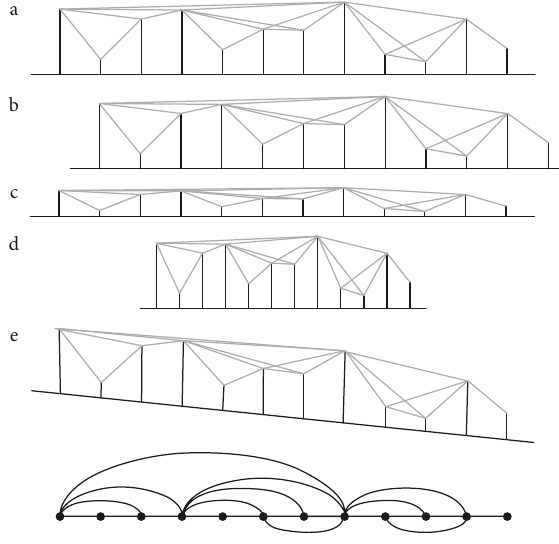
Figure 4: Visibility graph theory.